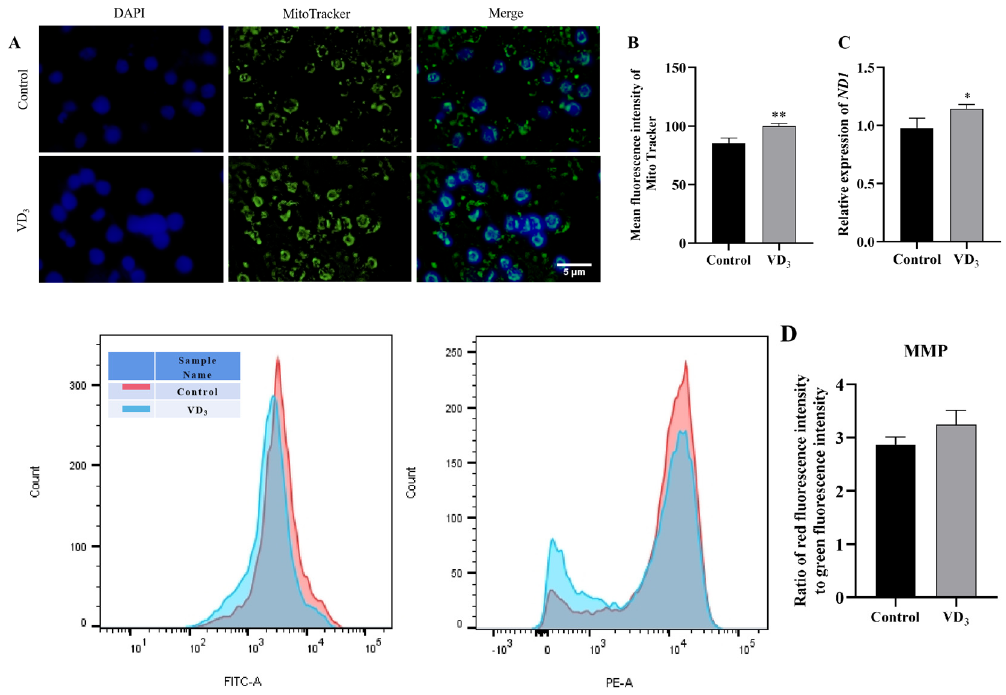
Figure 3. Mitochondria status in the 1 α ,25(OH) 2 D 3 -treated GCs. ( A ) The Mito-Tracker labeled mitochondria in PGCs, and ( B ) the fluorescence intensity of mitochondria (green) labeled by Mito-Tracker in PGCs. ( C ) Relative gene expression of ND1 in PGCs. ( D ) The mitochondrial membrane potential of PGCs. Blue fluorescence represented the nucleus. Bar = 5 µ m. VD 3 : 1 α ,25(OH) 2 D 3 . Data are means ± SE of three independent replicates (* p < 0.05, ** p < 0.01).